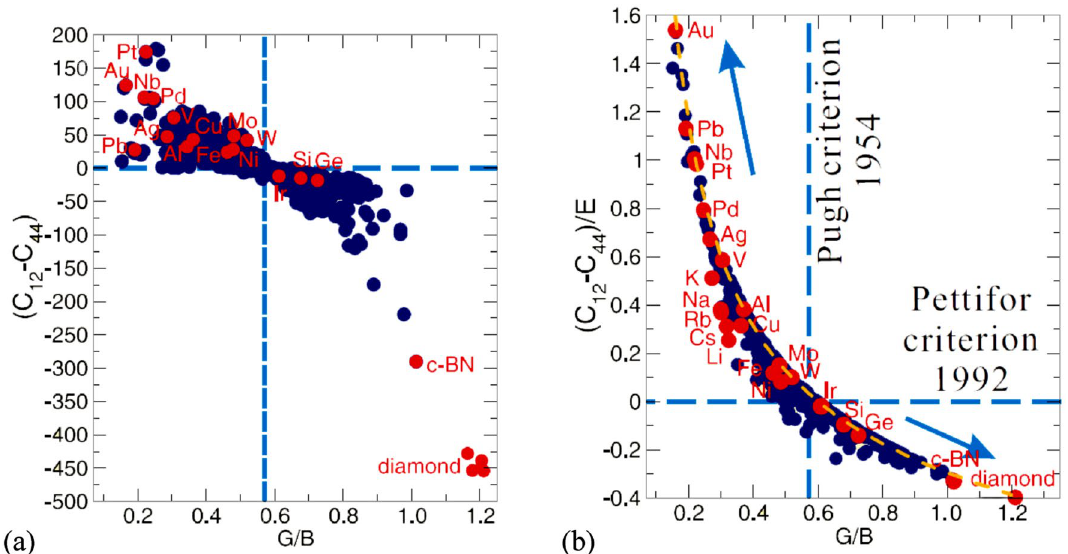
Figure 1. ( a ) Correlation between C” = (C 12 − C 44 ) and G/B for 308 compounds and 24 metals given in Supplementary materials of 5 ; (b) a renormalized hyperbolic correlation between C” normalized by Young modulus E and G/B for all the data from ( a ). The horizontal dashed line corresponds to C” = 0 and the vertical dashed line corresponds to G/B = 0.57. (Compiled from 5 .) A dashed yellow data trendline in ( b ) corresponds to Eq.